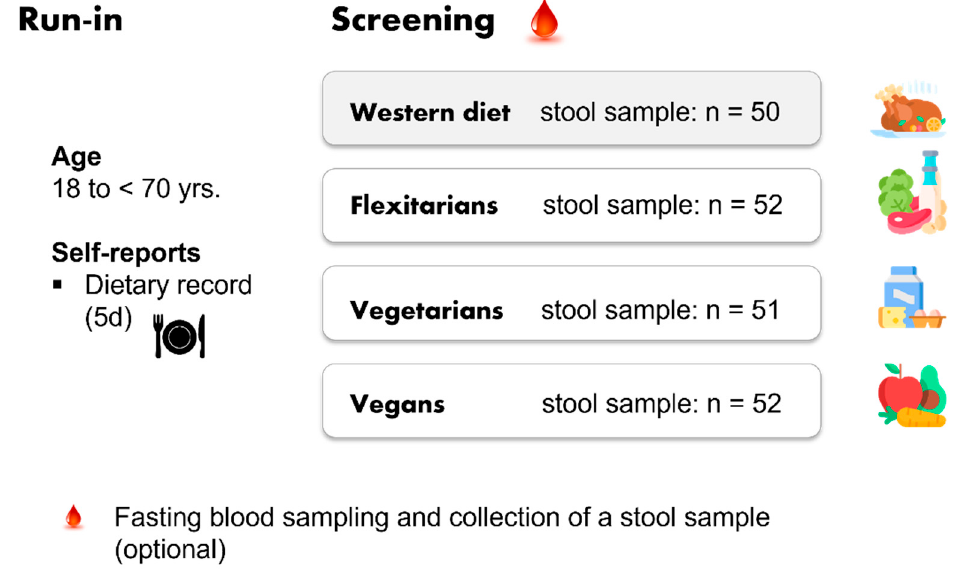
Figure 1. Study design—NuEva screening.